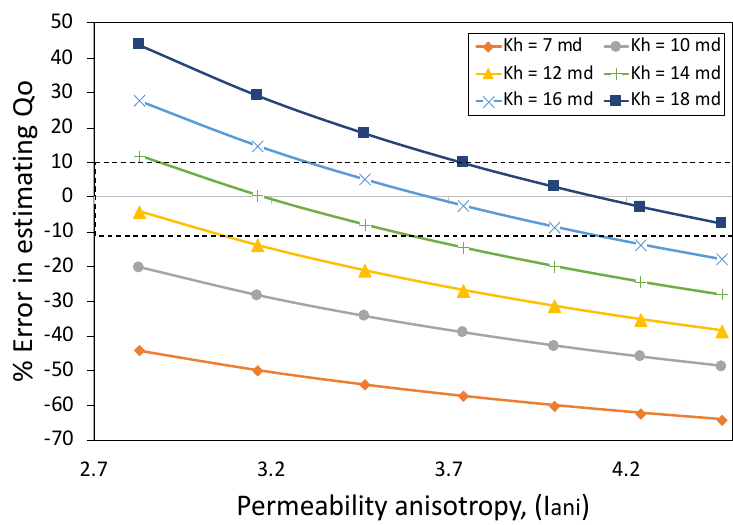
Figure 9. Errors in estimated well production rate; the coupled effect of uncertainties in horizontal permeability and permeability anisotropy (Well #1).